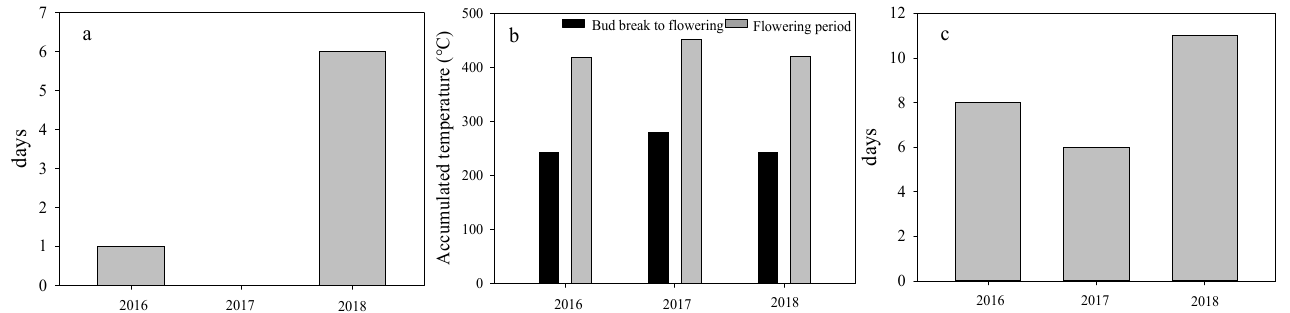
Figure 3. ( a ) Number of days when the average daily temperature was below 0 °C during the bud break period (March); ( b ) changes in accumulated temperature above 10 °C at key growth stages of apples in 2016–2018. The black square indicates the accumulated temperature above 10 °C from bud break to flowering (10 March–20 May), while the gray square indicates the accumulated temperature above 10 °C during the flowering period (1 April–31 May); and ( c ) number of days when the daily minimum temperature was below 0 °C from bud break to flowering (10 March–20 May).